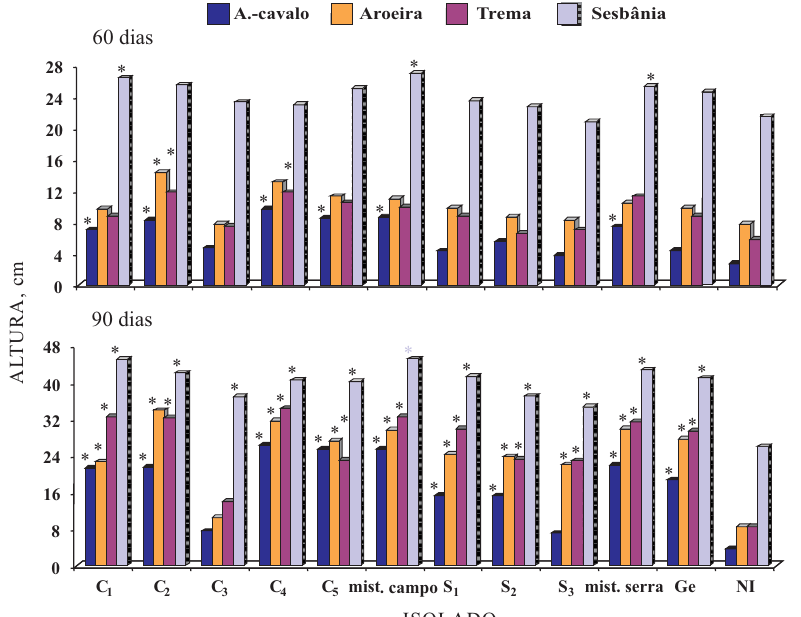
Figura 1. Altura das plantas aos 60 e 90 dias após o plantio. * Efeito significativo em relação ao não-inoculado : A. longula ; C : Paraglomus (NI) - Tukey a 5 %. C: FMAs isolados do campo; S: FMAs isolados da serra. C 1 2 occultum ; C : Glomus sp.; C : Gigaspora sp.; C : A. spinosa , mist. campo: mistura de todos os isolados do 3 4 5 campo; S : A. scrobiculata ; S : Paraglomus occultum ; S : Glomus sp.; mist. serra: mistura de todos os 1 2 3 isolados da serra; Ge: G. etunicatum